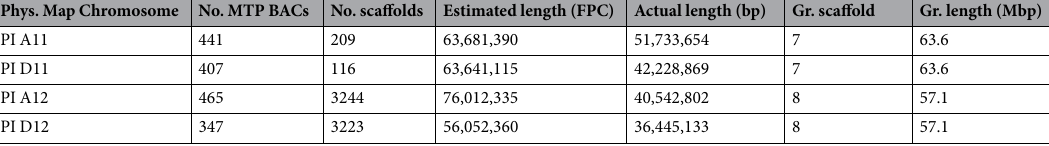
Table 3. Large and small clone pool sequencing of homeologous chromosome pairs A11/D11 and